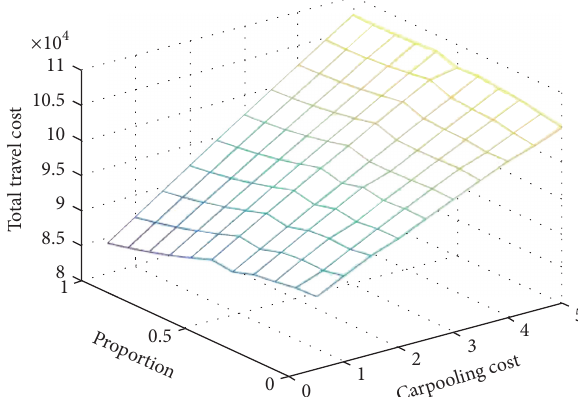
Figure 3: The total travel costs with various carpooling costs and